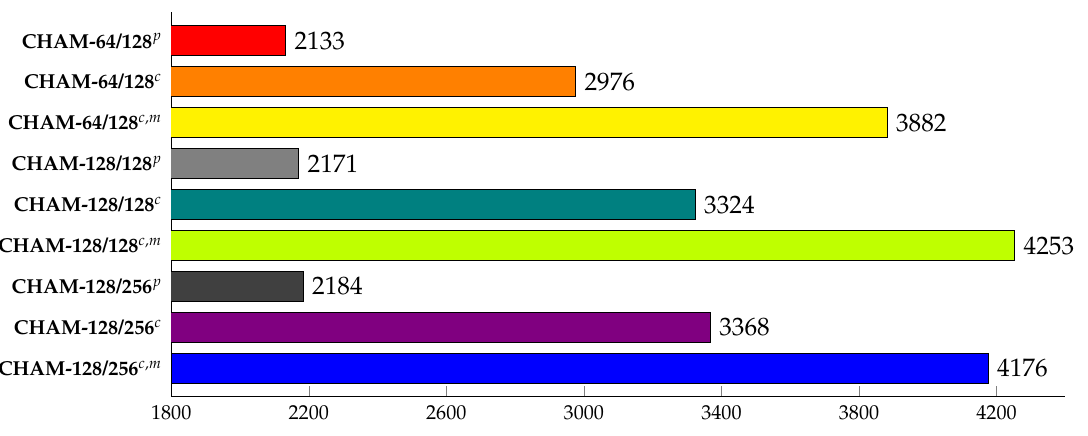
Figure 22. Comparison of throughput (MB/s) for CHAM implementations on GPU platform including memory copy time, where p , c , and m represent parallel Electronic CodeBook (ECB) mode of operation, parallel CTR mode of operation, and GPU memory optimization, respectively.(CHAM-n/m means n-bit plaintext encryption with the m-bit